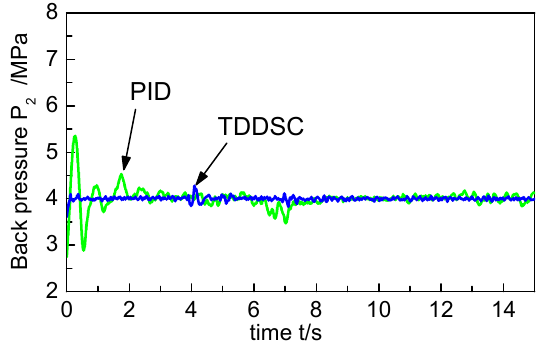
Figure 15. Rod chamber pressure as a function of time.